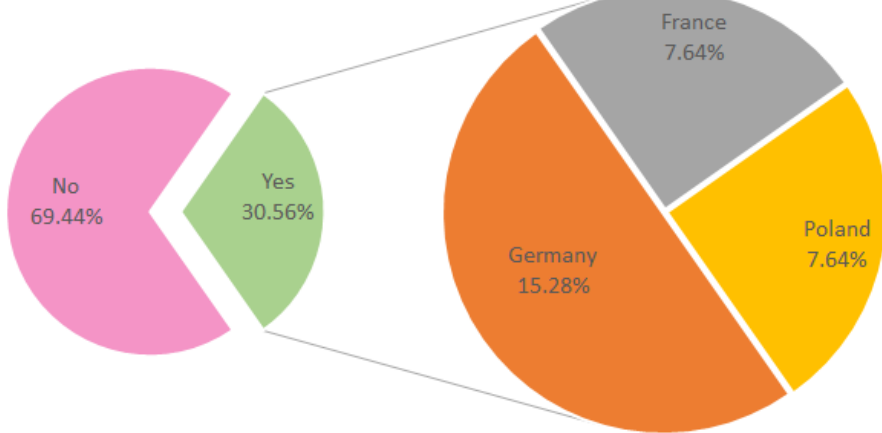
Figure 5. Changes in car-sharing business models from a geographic point of view.